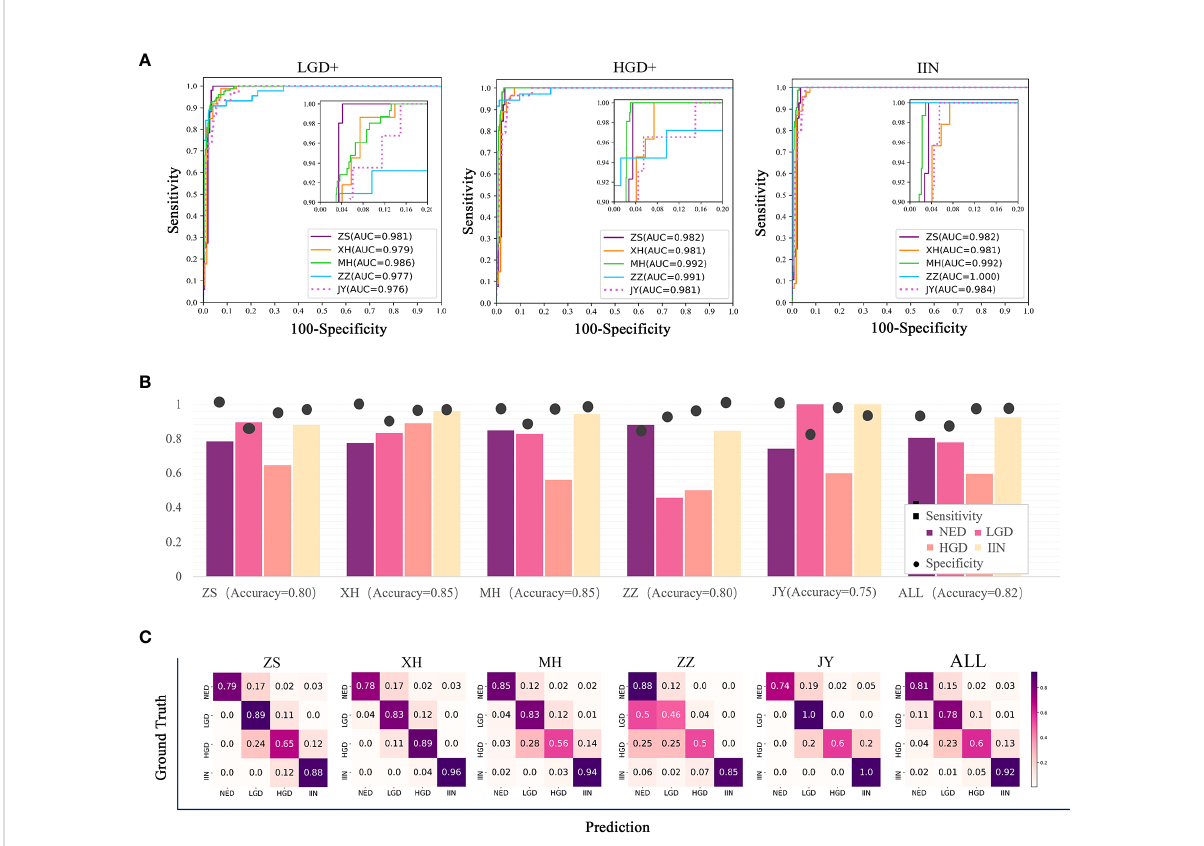
FIGURE 3 Results of the assessment of the endoscopic gastric biopsy assistant system on the large-scale test dataset. (A) The receiver-operating curve (ROC) of screening negative for dysplasia (NED) cases in four centers. The area under the curve (AUC) was 0·981, 0·979, 0·986, 0·977, and 0·976 in ZS, XH, MH, ZZ, and JY. The average AUC was 0·979 in the fi ve centers. (B) Assessment of pathology slide classi fi cation. The accuracy, sensitivity, and speci fi city of detecting the four categories in all centers are presented. For NED, low-grade dysplasia (LGD), high-grade dysplasia (HGD), and intramucosal invasive neoplasia (IIN) categories, separate accuracy ranged from 0·750 to 0·850, sensitivity ranged from 0·632 to 0·926, and speci fi city ranged from 0·90 to 0·912. (C) Classi fi cation confusion matrix of the large-scale test dataset, which indicates the distribution of the predicted label on the true label. ZS, Zhongshan Hospital; XH, Central Hospital of Xuhui District; MH, Central Hospital of Minhang District; ZZ, Zhengzhou Central Hospital; JY, Jiangyin Hospital Af fi liated to Nanjing University of Chinese